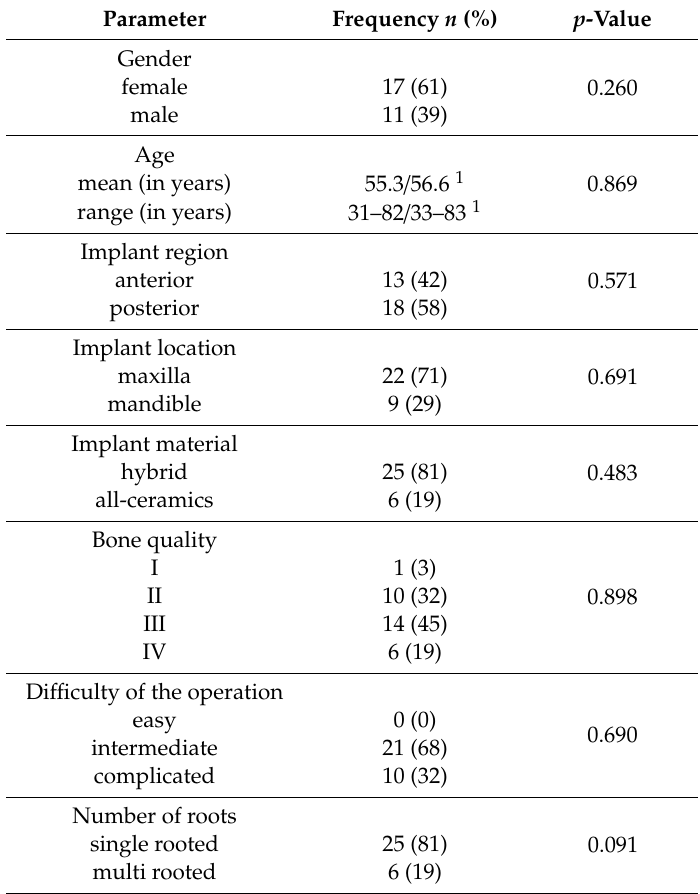
Table 3. Patient characteristics and p -values for investigated influence on